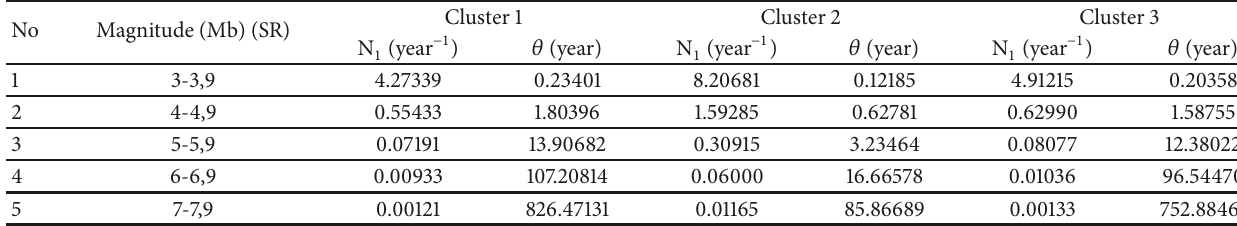
Table 2: Seismicity and return period of earthquake for each